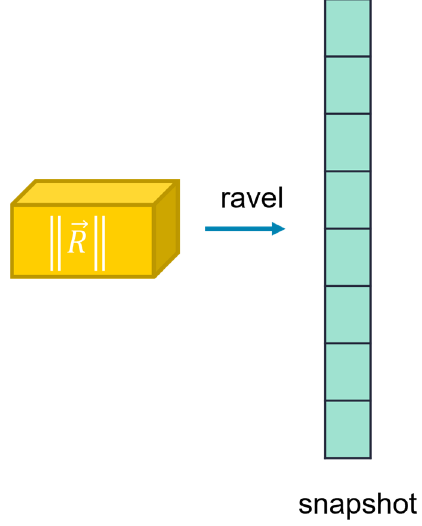
Figure 6. Raveling 3D (cid:3630)(cid:1844)(cid:4652)⃗(cid:3630) field to 1D array.